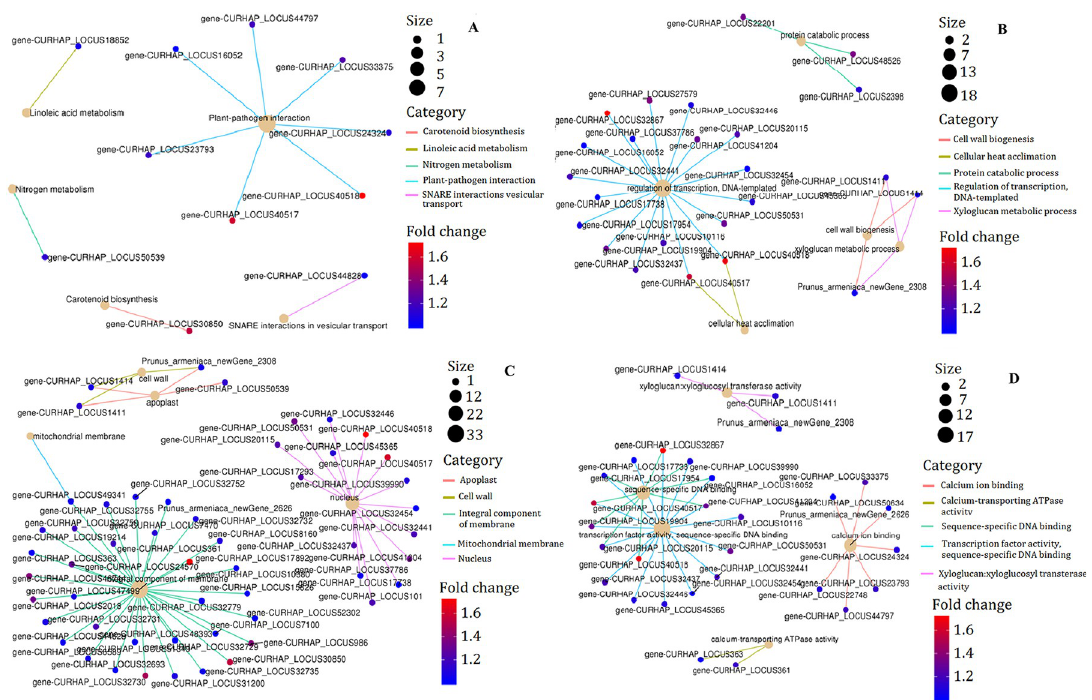
Fig 6. Enrich center plot of DEGs between long branches and spur twigs at Stage III. (A) KEGG. (B) Biological process component of GO classify. (C) Cellular component of GO classify. (D) Molecular function of GO classify. Red indicates high expression; blue indicates low expression; the color of lines indicates different pathways, and the color of gene nodes indicates fold of difference. The larger the nodes represents the more genes are enriched into this pathway.